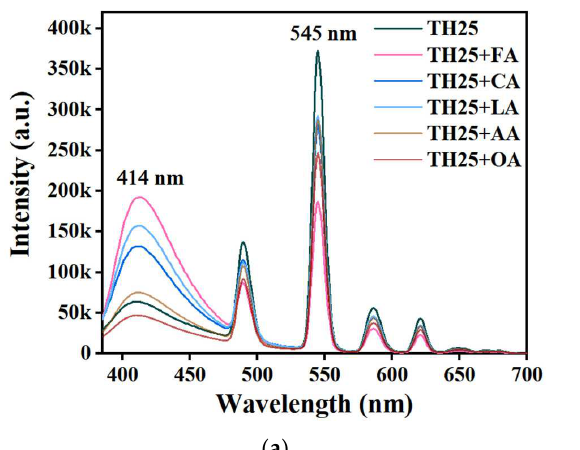
(LOD: limit of detection, δ : the standard deviation of blank parallel measurement (repeated more than 10 times), k : the slope of the fitted line, 0.00109, the specific calculation process is shown in supporting information), the LOD of TH25 for FA is 2.1 ppm. Compared with other existing sensors of FA, TH25 is the only fluorescent sensor for liquid FA, which is not only simple to operate but also exhibits a relatively low LOD (Table 1). In summary, TH25 is proved to be a good ratiometric fluorescent sensor for